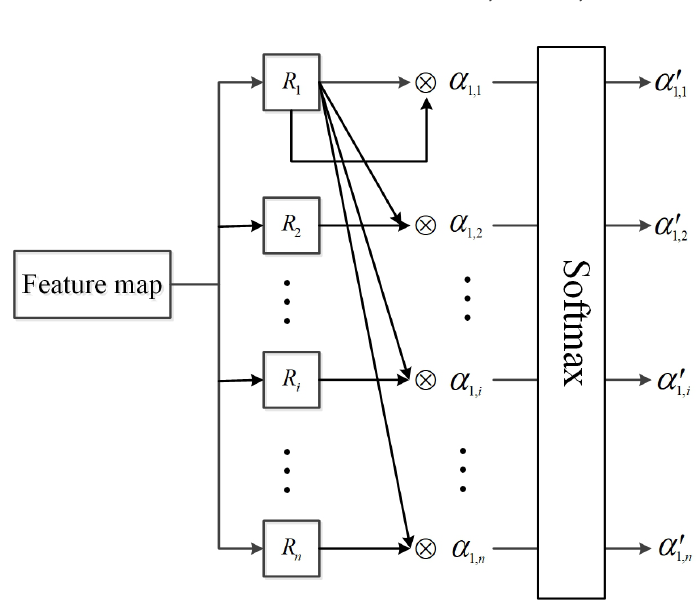
Figure 7. Sketch of calculating the similarity between region